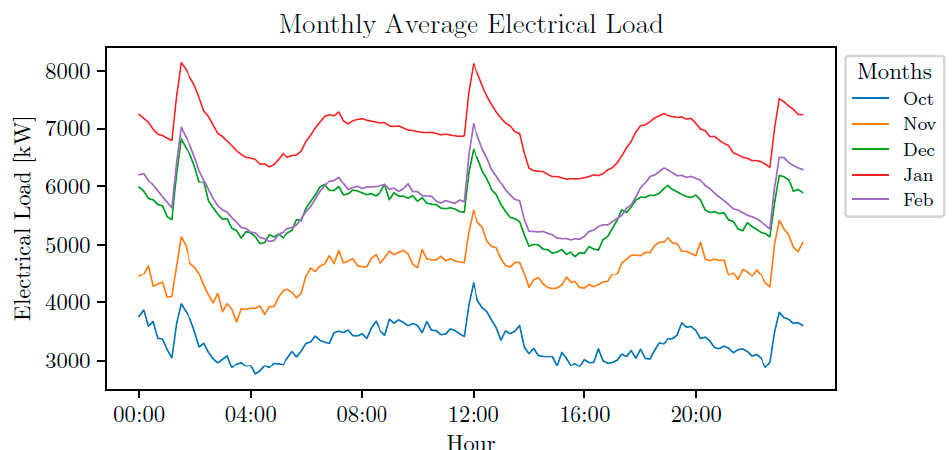
Figure 6. Electrical load monthly average.